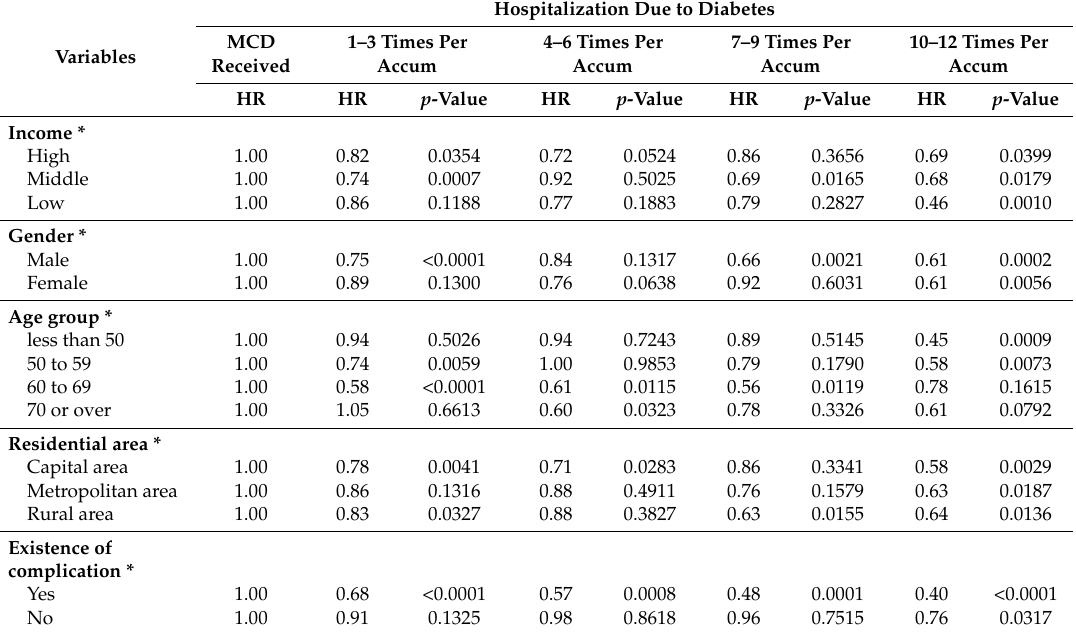
Subgroup analyses of the association between management of chronic disease and hospitalization due to diabetes stratified by income, gender, age group, residential area and presence of